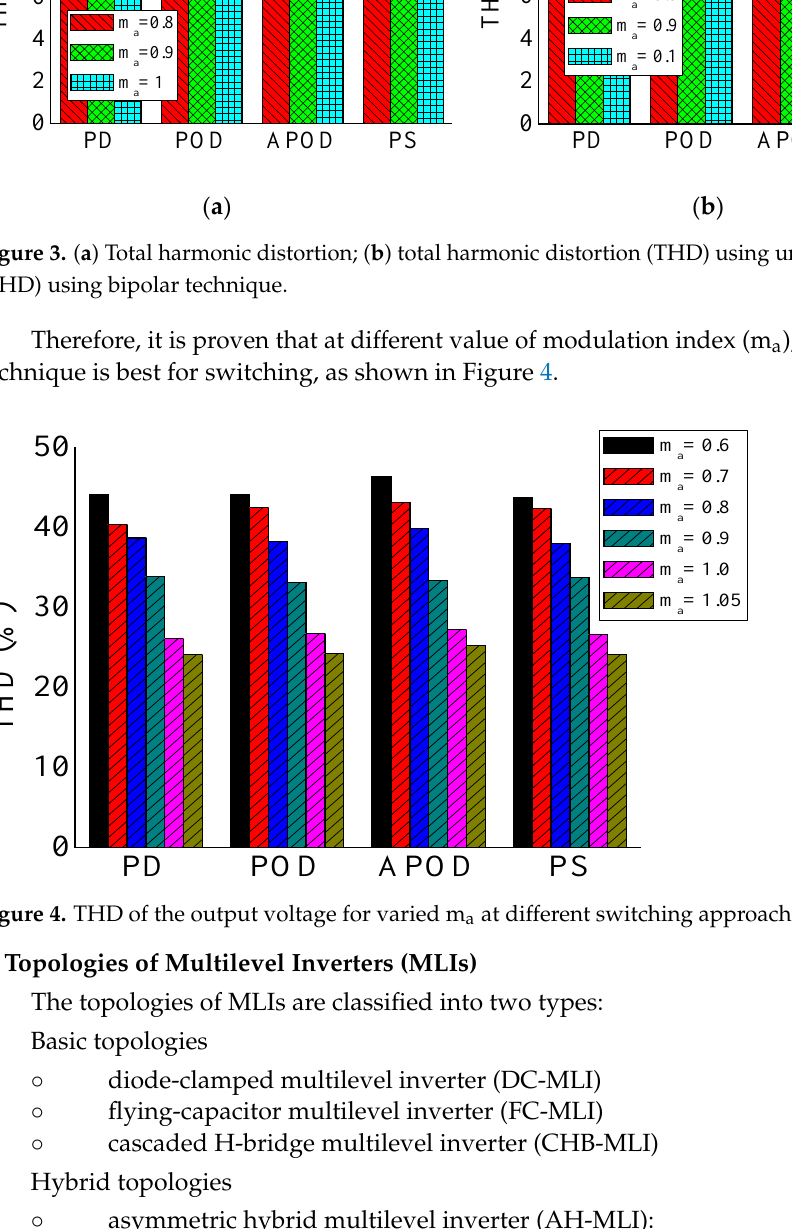
a 0 n Figure 5. Circuit topologies for 5-leveldiode-clamped multilevel inverters. In each leg, four parallel switch pairs are installed. The parallel switch pairs are set up in such a way that turning on one prevents the other from turning on. (S 1 , S 1 ′), (S 2 , S 2 ′),